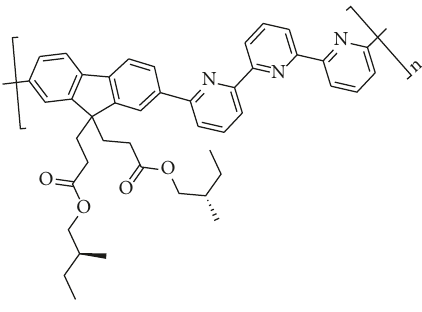
Figure 1: Structure of